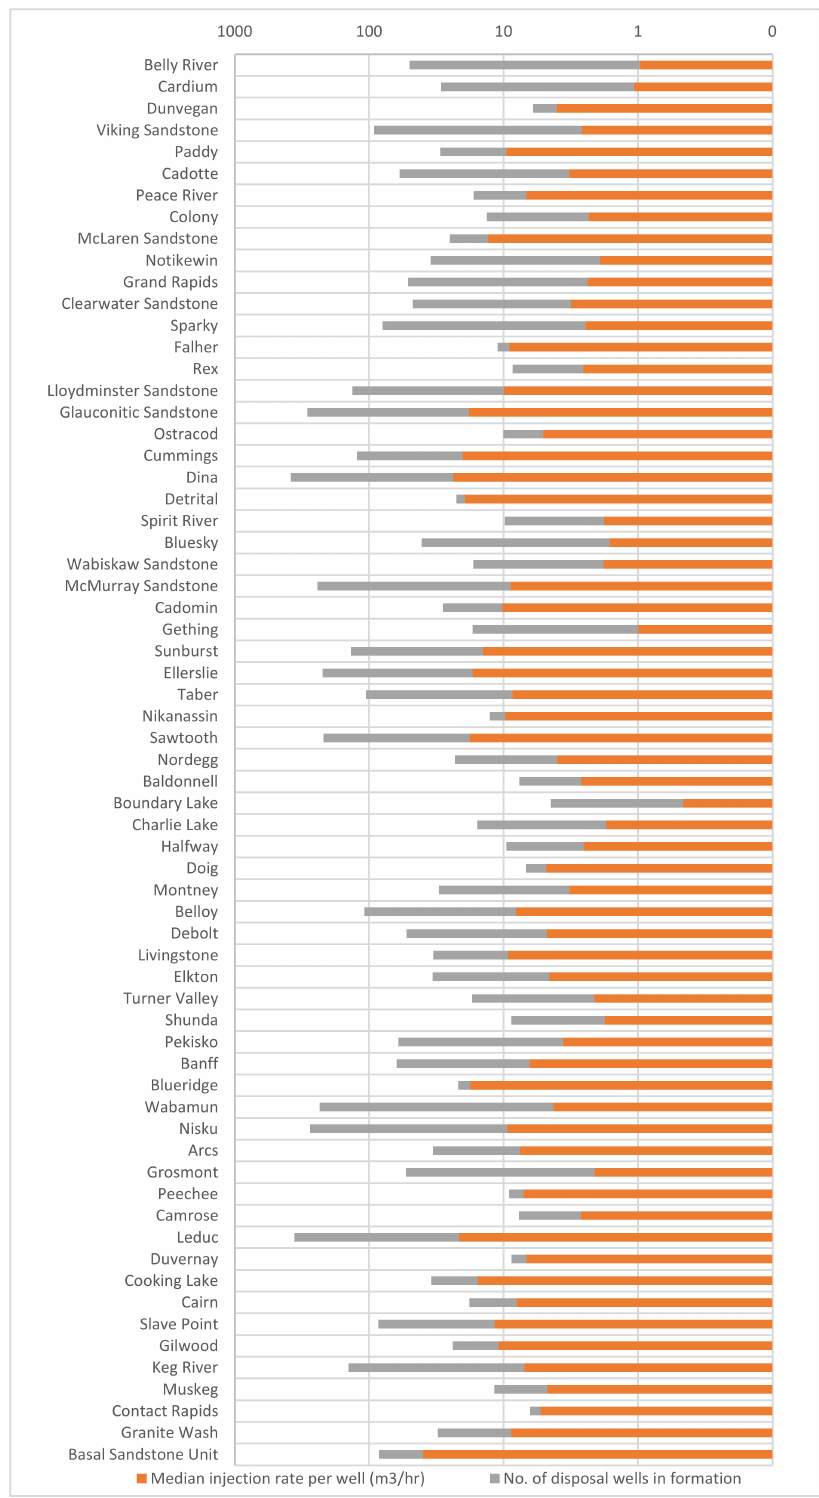
Figure 5. Comparison of median water injection rates and number of disposal wells in formations of interest in the Alberta Basin (for period January 1962–December